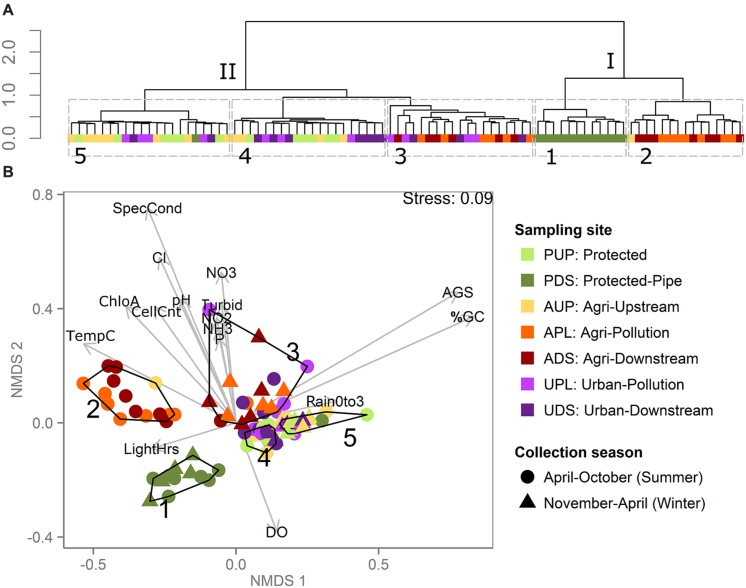
Metagenomes clustered by reference-free k-mer analysis show effect of sampling site, weather conditions, and water chemistry. (A) Hierarchical clustering of samples based on metagenome k-mer composition. Each terminal node (leaf) is a sample, colored by sampling site. Roman numerals label major clusters, Arabic numerals label sub-clusters outlined in gray dashed lines. (B) NMDS plot based on k-mer abundance distributions in which each point represents a sample, colored by sampling site. Clusters outlined and numbered in black correspond to numbered clusters in (A). Environmental variables were correlated with ordination axes using envfit and are displayed using gray arrows, where lengths of arrows correspond to the strength of the correlation between the variable and the ordination (only variables with p < 0.05 displayed) and direction corresponds to increasing value (e.g., samples closer to the bottom of the plot have higher DO). Environmental measures are abbreviated as in Table 2. The percentage of nucleotides that are G or C is abbreviated as “%GC”. Sampling site is the major distinction among metagenomes from flowing surface water versus water collected from a reservoir-fed pipe (PDS). Among surface water samples, clustering reflects samples’ collection date, water chemistry and land use.